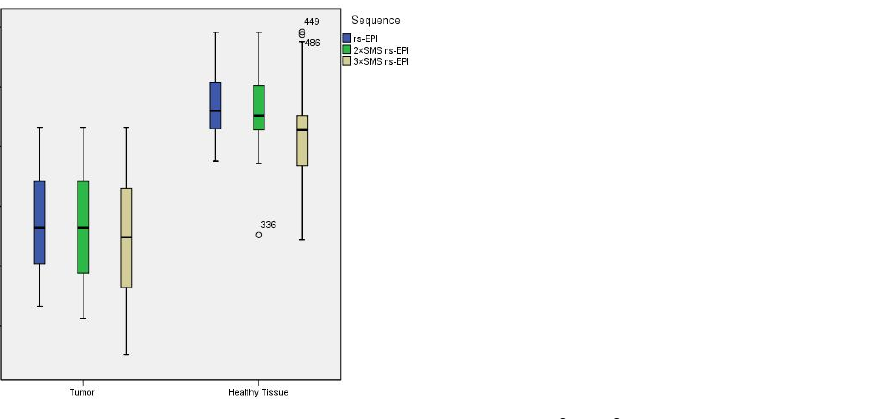
Figure 4. Box plot of the differences between ADC values (10 − 3 mm 2 /s) in tumors and healthy tissue measured using the three sequences.